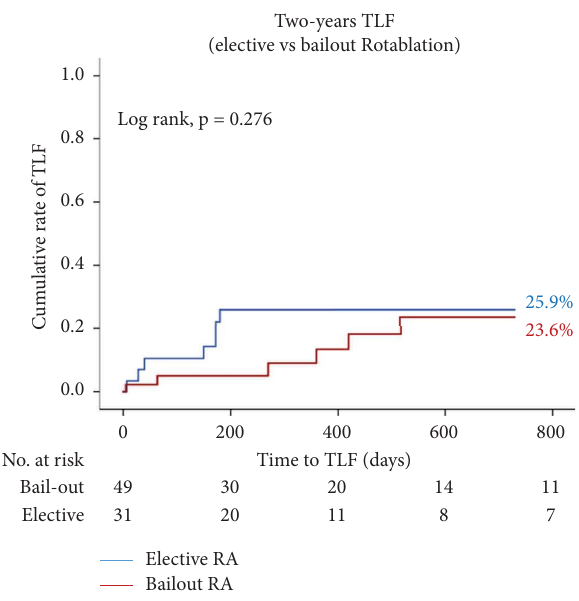
Figure 2: Kaplan–Meier curves of the two-year target lesion failure (TLF) rate. Te cumulative rate of the 2-year target lesion failure (TLF) in bail-out versus elective rotational atherectomy (RA) for chronic total occlusion (CTO)